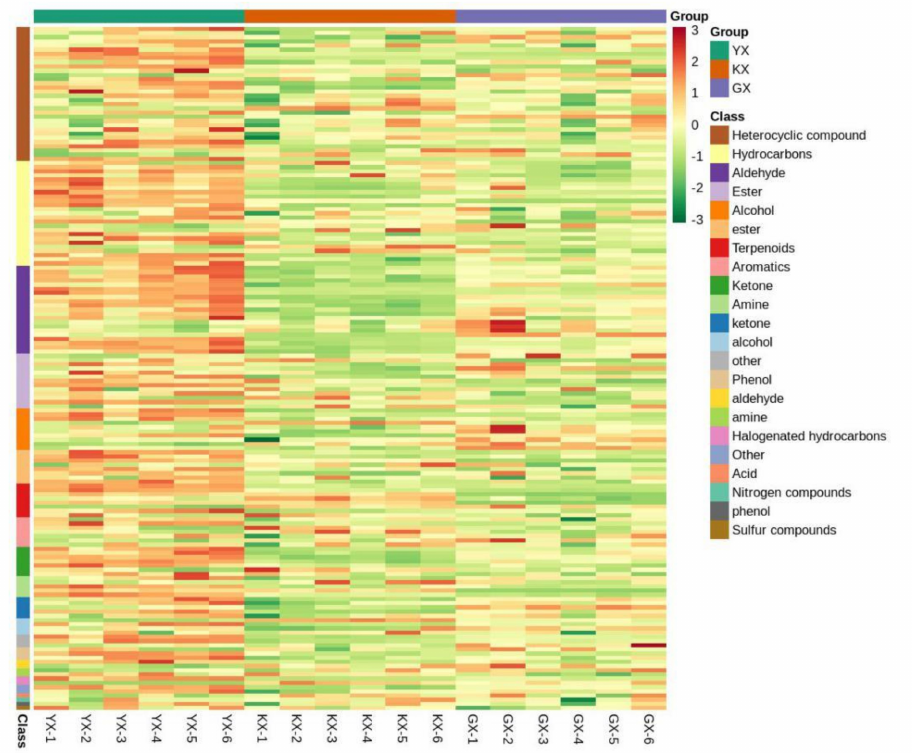
Figure 4. Overall clustering heatmap of samples of three cucumber cultivars YX, KX and